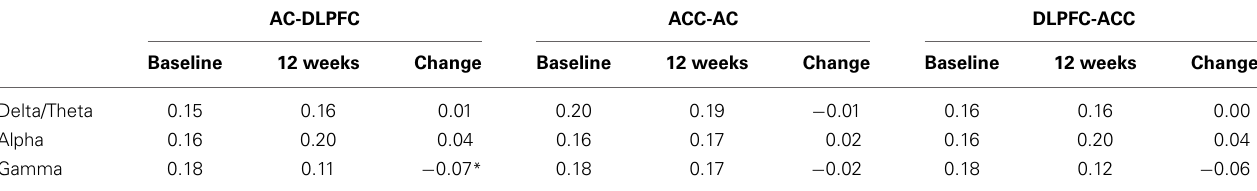
Table 3 | Phase synchronization between selected regions for the selected frequency